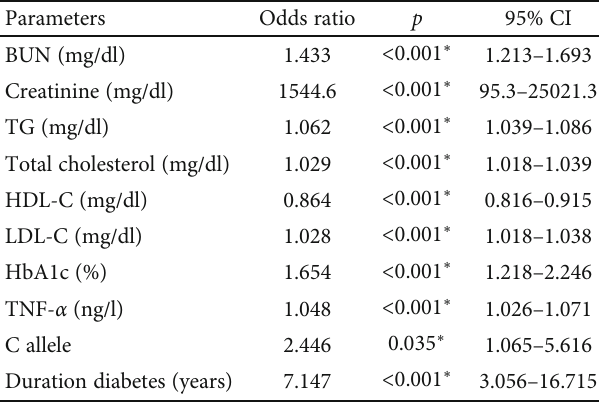
Table 5: Multivariate logistic regression model for the risk factors of